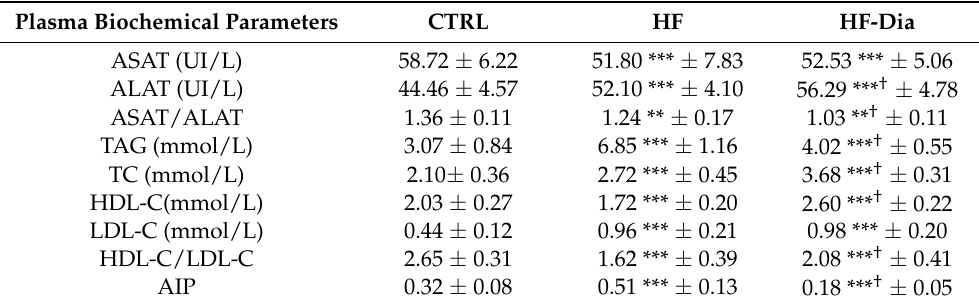
Table 1. Effects of D. lutheri on plasma biochemical parameters. Plasma Biochemical